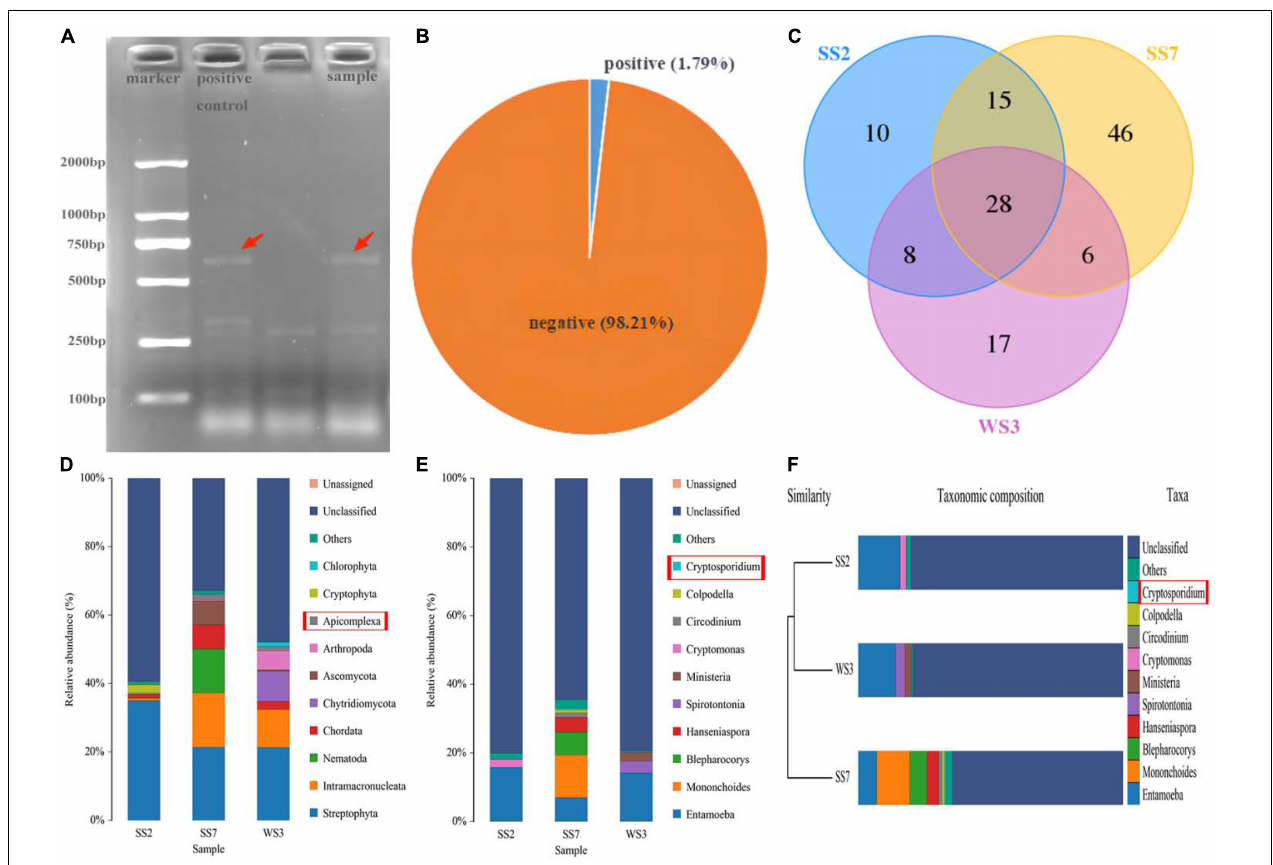
FIGURE 1 | The confirmed positive samples using nested PCR and 18S rDNA high-throughput sequencing. (A) Agarose gel electrophoresis. The target bnands are pointed by the red arrows. The first well is a positive control, while the other is a test sample; (B) the prevalence of natural infection of Cryptosporidium spp. in horses; (C) unique and core OTUs of positive samples; (D,E) double confirmation of positive samples through 18S high-throughput sequencing; (F) cryptosporidium is belonging to the top 10 abundant genus in UPGMA clustering tree.